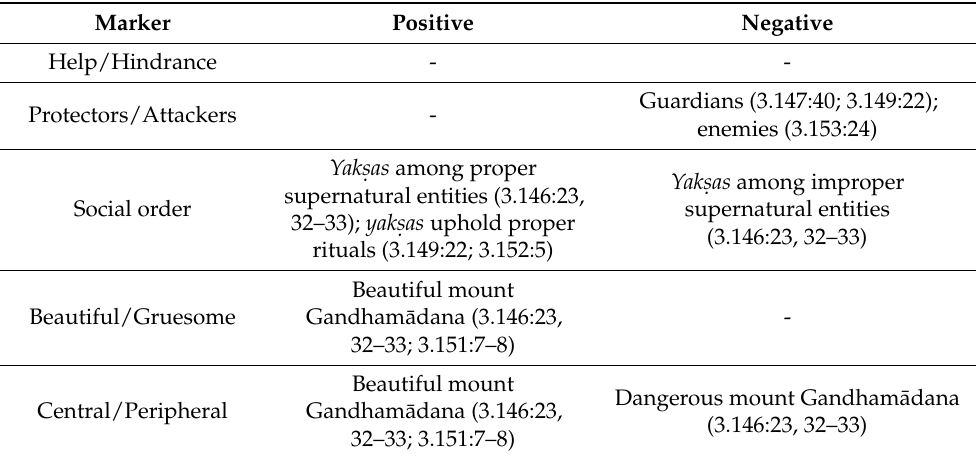
Table 2. Evaluation of the yaks.as in the First War of the Yaks.as